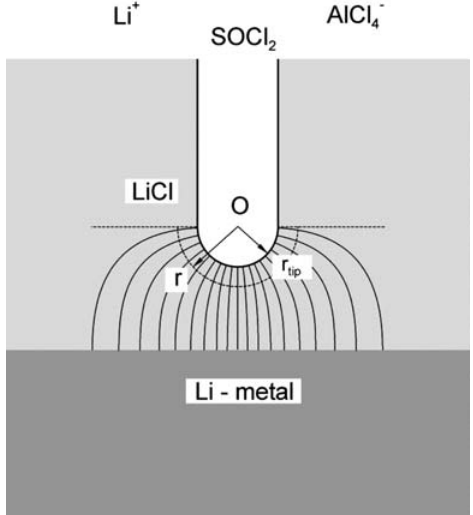
Figure 7. Illustration of the concept behind eqs. (16)–(19). With ro- tational symmetry it shows a cylindrical hole ending in a semi- sphere, eqs. (16)–(17a). If a cross-section through a crack is imagi- ned then it shows a crack with a tip of semi-cylindrical